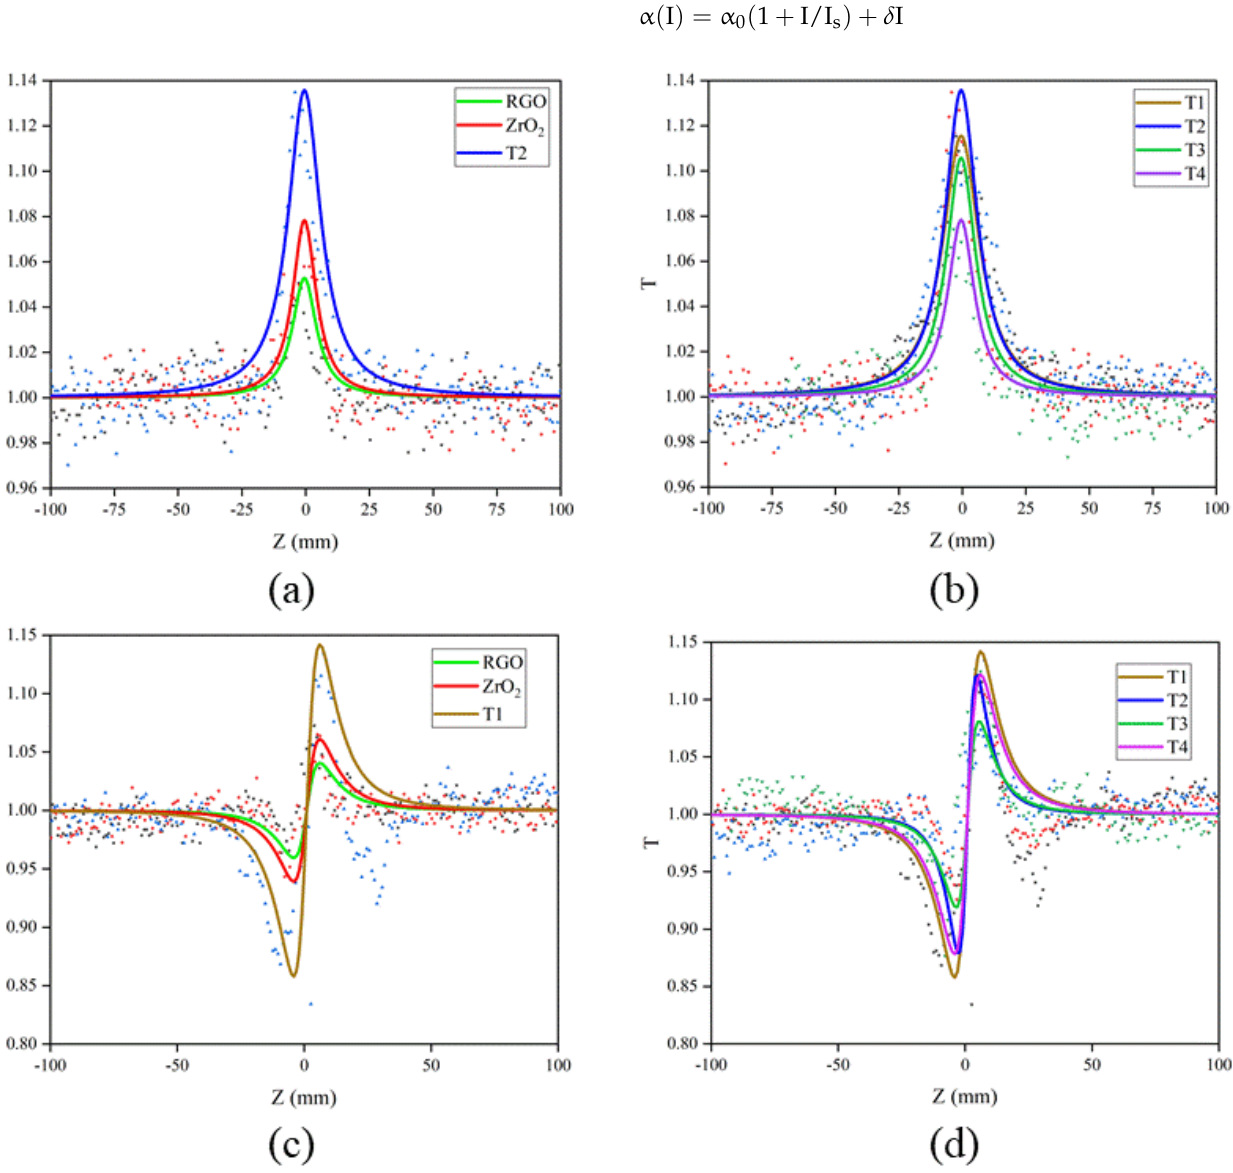
Figure 7. (a) Open-aperture Z-scan curves of RGO, ZrO 2 , and the ZrO 2 /RGO composite T2; ( b ) Open-aperture Z-scan curves of composites T1-T4; ( c ) Closed-aperture/open–aperture Z-scan curves of RGO, ZrO 2 , and the ZrO 2 /RGO composite T2; ( d ) Closed-aperture/open-aperture Z–scan curves of composites T1-T4.